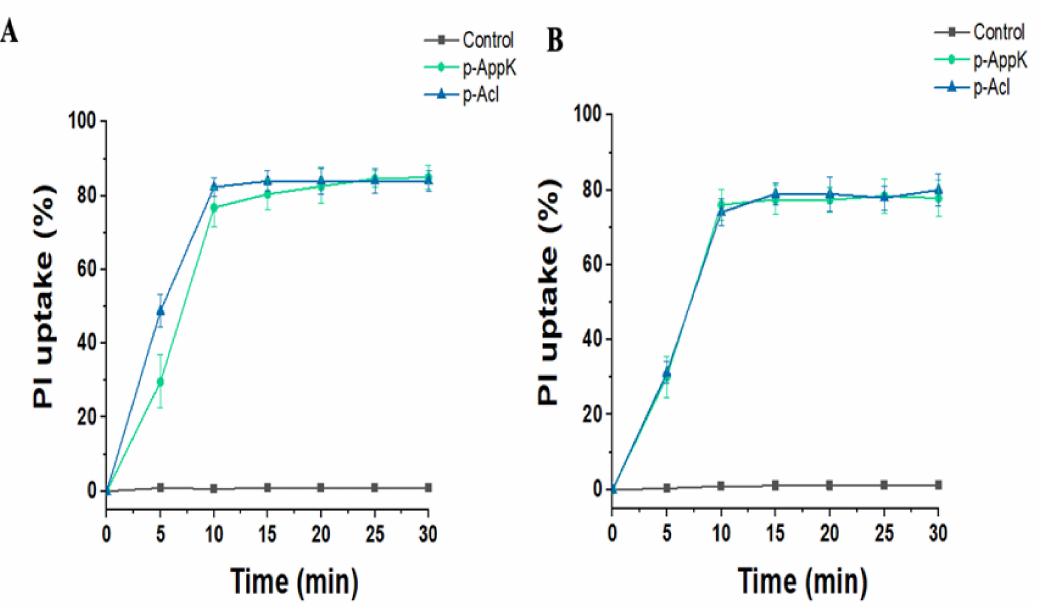
Figure 3. In vitro membrane-disruptive activity provoked by p-AppK (green) and p-Acl (blue). The membrane integrity evaluation of ( A ) P. aeruginosa ATCC and ( B ) S. aureus BEC9393 incubated with 100 µ M peptides was determined as a function of fluorescent dye